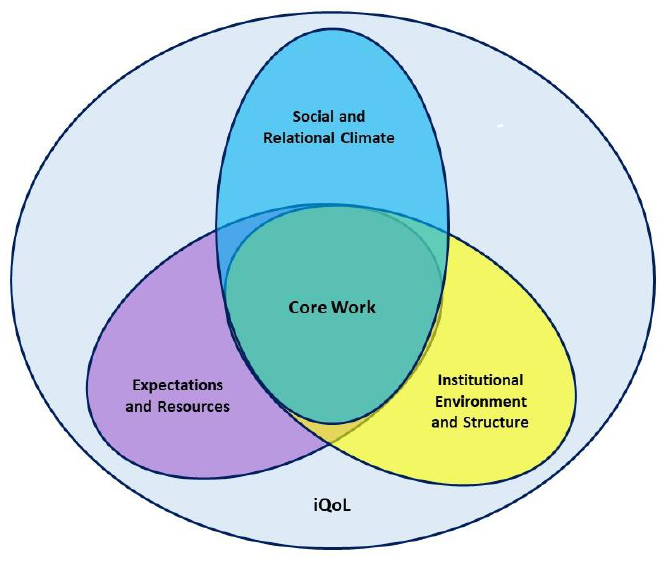
Figure 1. Conceptual representation of the factors influencing intellectual quality of life (iQoL).